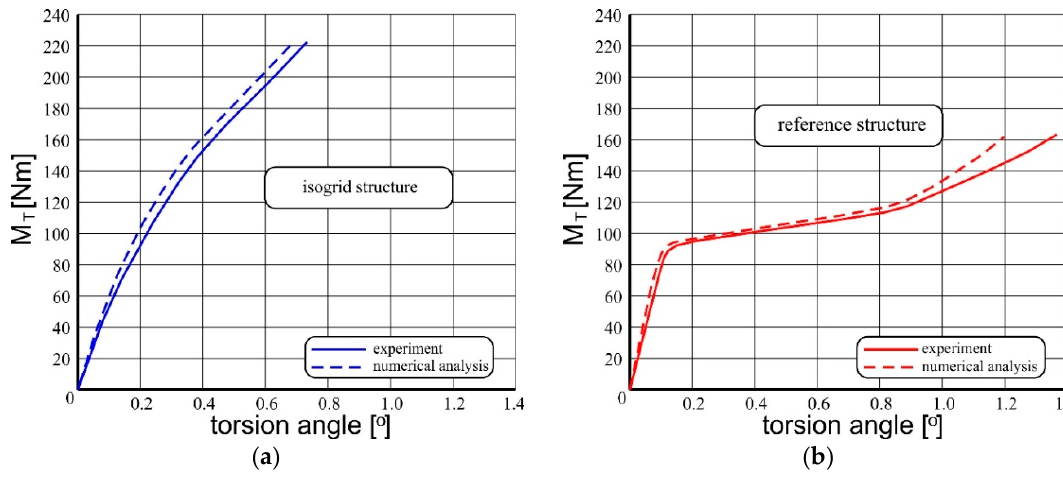
Figure 7. List of representative equilibrium paths obtained in numerical way and as a result of the experiment: ( a ) structure stiffened with isogrid, ( b ) reference structure.